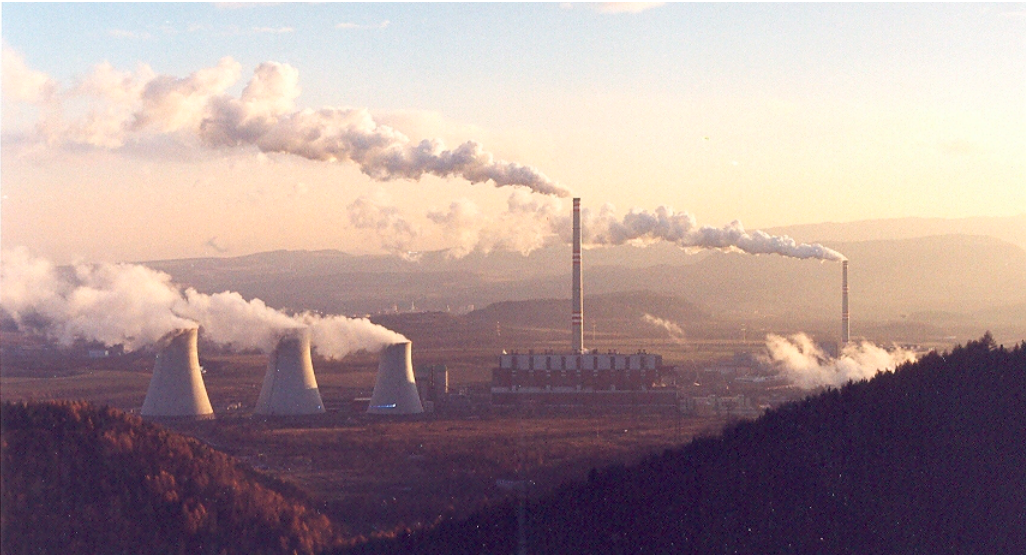
Figure 1. Prunerov coal power plant (photo by the author).